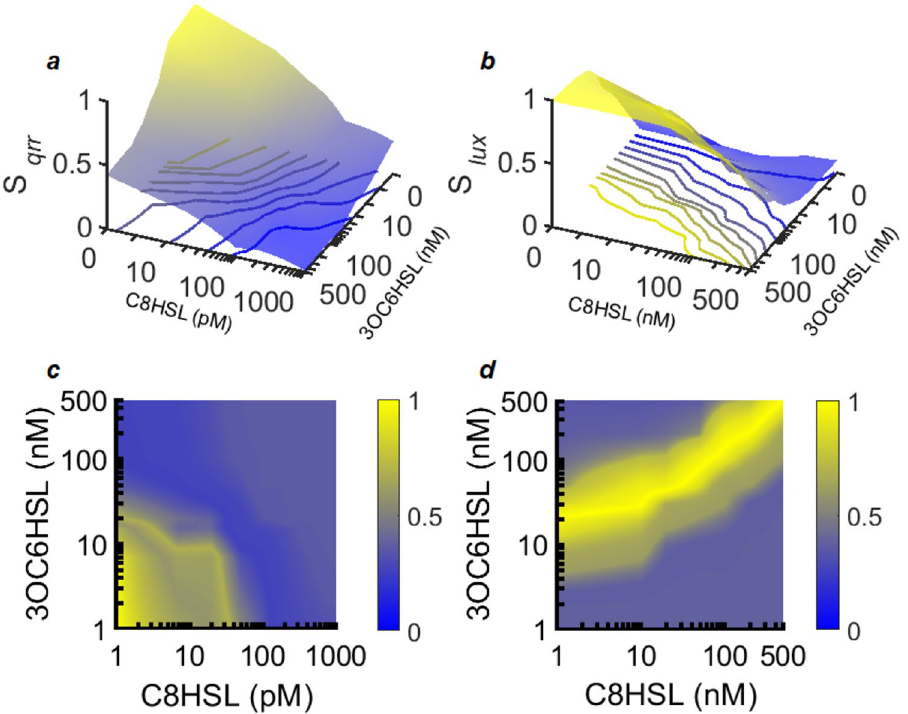
Figure 7. HSL-dependent response of the AinS/R and LuxI/R circuits is expressed in terms of the NLPCA coordinates S qrr and S lux . These coordinates correspond to position (arc length) along the solid curve in Fig. 6a (for qrr ) or Fig. 6c (for lux ), where they capture > 92–97% of the HSL-dependence of the statistical distributions of individual cell behavior. S qrr and S lux are scaled to lie in the range 0 → 1 and are plotted with respect to HSL concentrations for (a) qrr and (b) lux. The color maps in (c) and (d) show the probability distributions for C8HSL and 3OC6HSL concentrations that would lead to flat probability distributions for (c) S qrr and (d) S lux . That is, they show the HSL input probabilities for which all values of the NLPCA coordinate S would be equally probable. They indicate the HSL concentrations at which the S qrr and S lux surfaces in (a,b) have steepest slope and are changing most